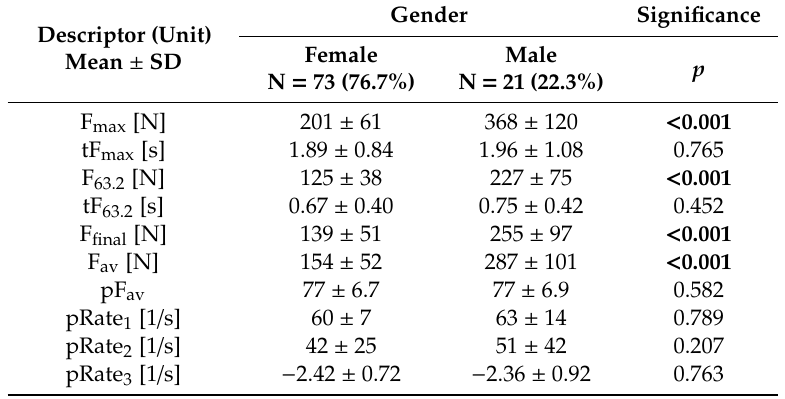
Table 2. Means, standard deviations and gender comparisons of the descriptors.